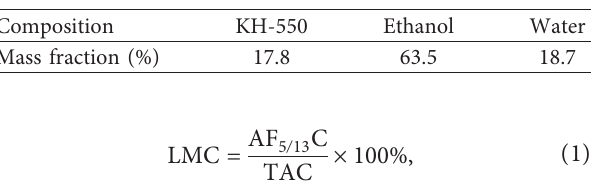
Figure 3: Schematic diagram of the RAP rinsing process. Table 6: Formulation ratio of SCA